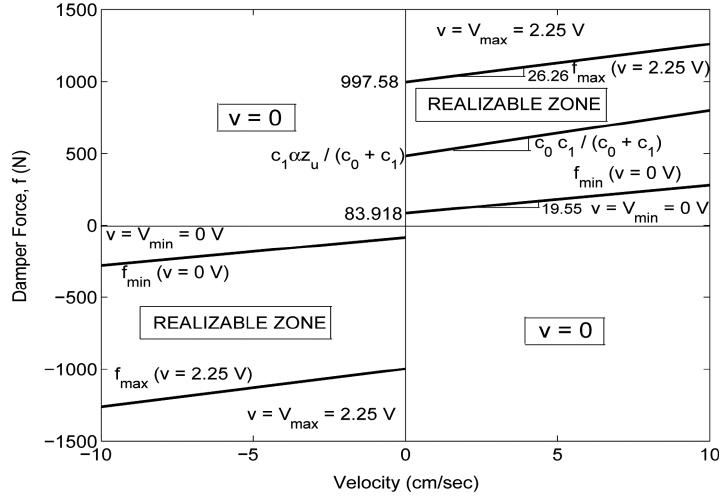
Fig. 2. Realizable zone of MR damper force in fi rst and third quadrant of f − ˙ x